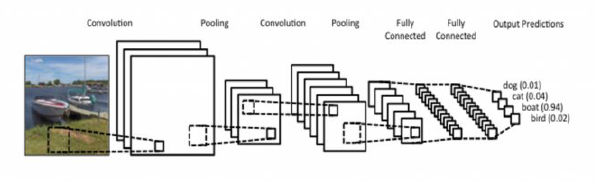
Figure 3. Convolution neural network (Gandhi,